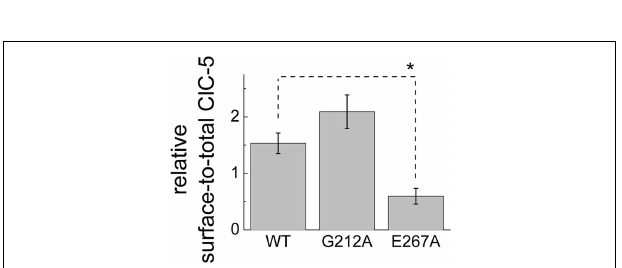
FIGURE 4 | Relative surface expression of WT and disease-associated ClC-5 mutants. Ratio of the surface ClC-5 assessed by HRP chemi-luminescence from an antibody targeting a HA tag engineered in one of the extracellular ClC-5 loops (proportional to the surface expressed ClC-5) and the fluorescence of the mCherry bound to the C-termini of the investigated constructs (proportional to the total ClC-5 expression). The significant difference between WT and E267 ClC-5 at the level of 0.05 is indicated by a